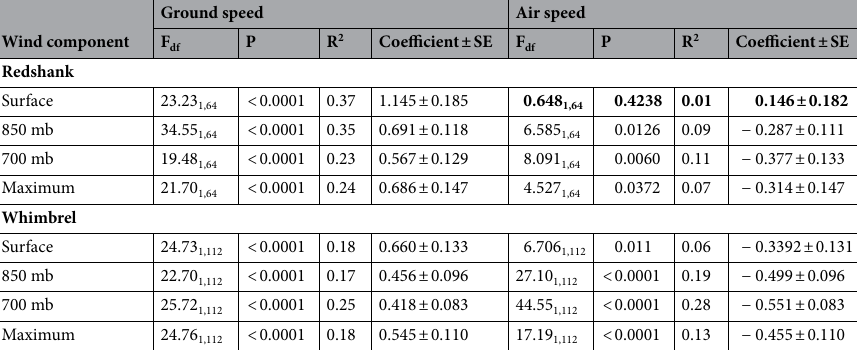
Table 4. Effect of wind support on flight speed for Common Redshanks and Whimbrels. Statistics are from linear regressions of ground speed estimated from short-term satellite-tracking estimates and calculated wind support. Overall regression statistics are provided, along with the coefficient of the relationship if significant. Coefficients represent the change in ground speed or air speed in km h −1 with an increase of 1 km h −1 in wind support. Non-significant models are shown in bold.